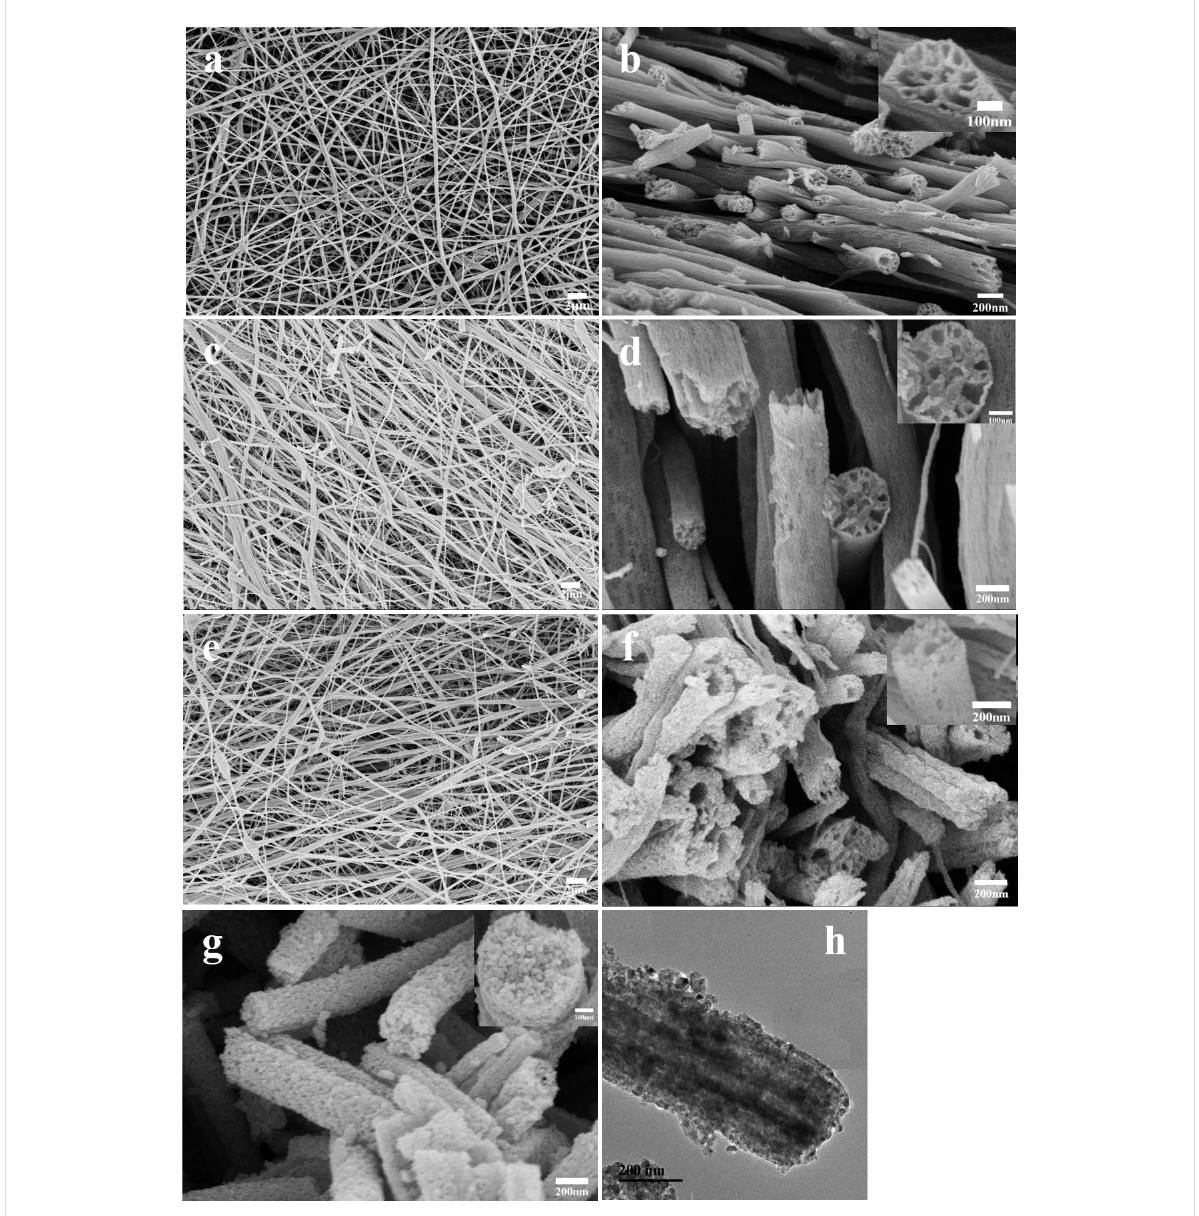
Figure 4: Surface SEM images of sample A 1 (a), sample B 1 (c), and sample C 1 (e); cross-sectional SEM images of sample A 2 (b), sample B 2 (d), sample C 2 (f) and solid TiO 2 nanofibers (g), inset SEM images were the corresponding images with higher magnification; and representative TEM images of sample A 2